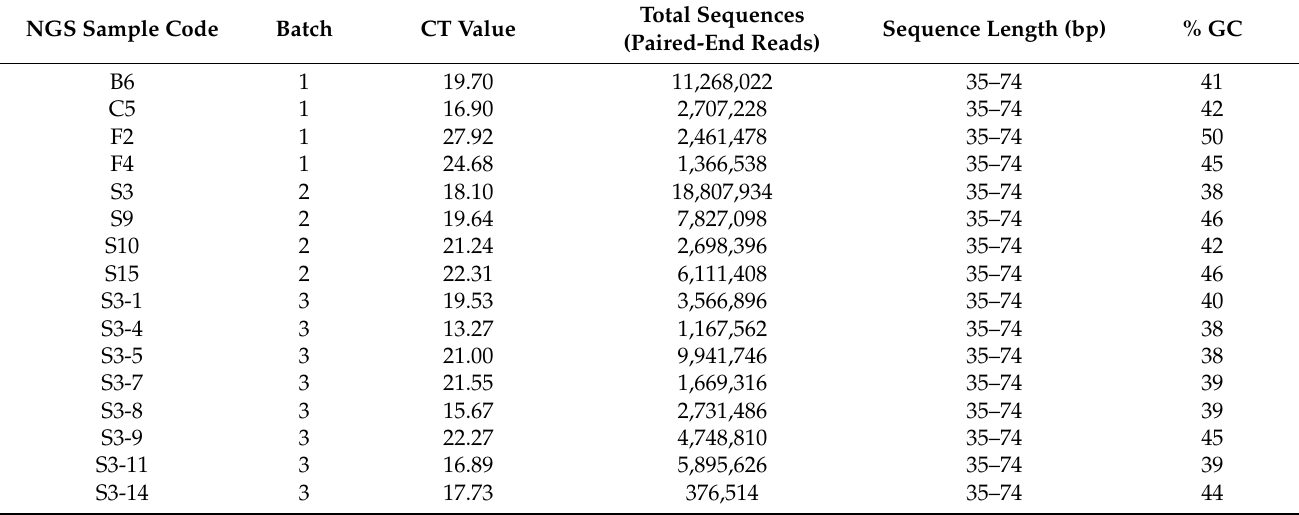
Table 2. The overview of WGS data that were involved in the